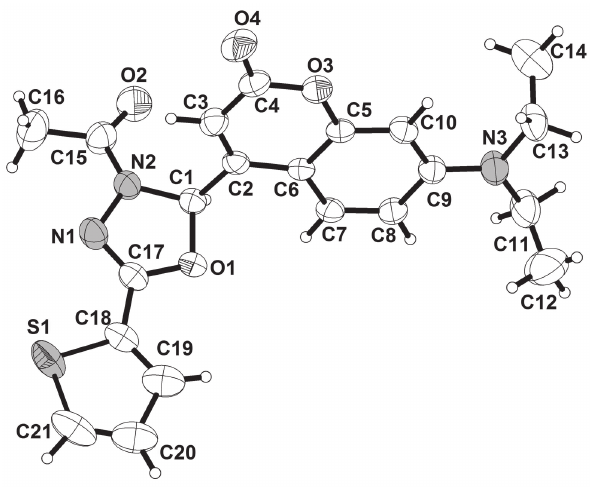
Table 1: Data collection and